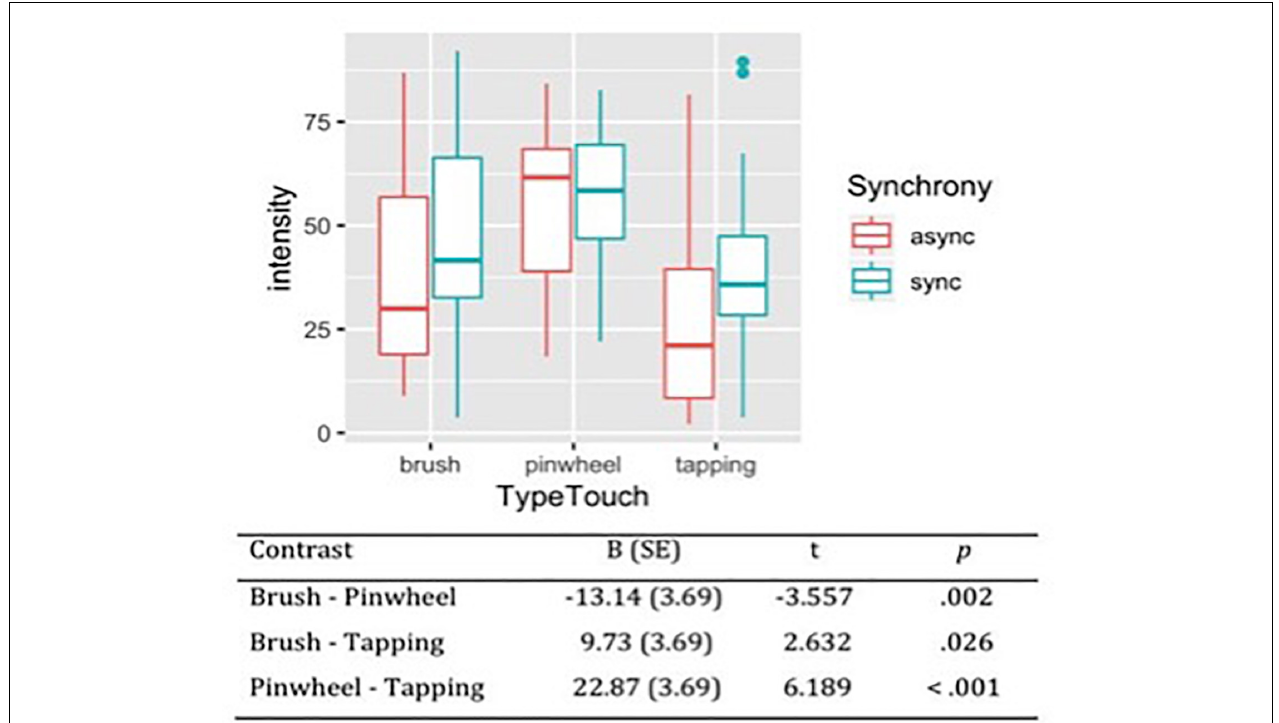
FIGURE 4 | Subjective intensity of tactile stimulations measured on VAS scale from 0 (least intense) to 100 (most intense). Contrasts between different types of touch have been reported, showing that the perceived intensity of the tactile stimulation was maximal for rubbing with a pinwheel, intermediate for stroking with a brush and minimal for tapping with a